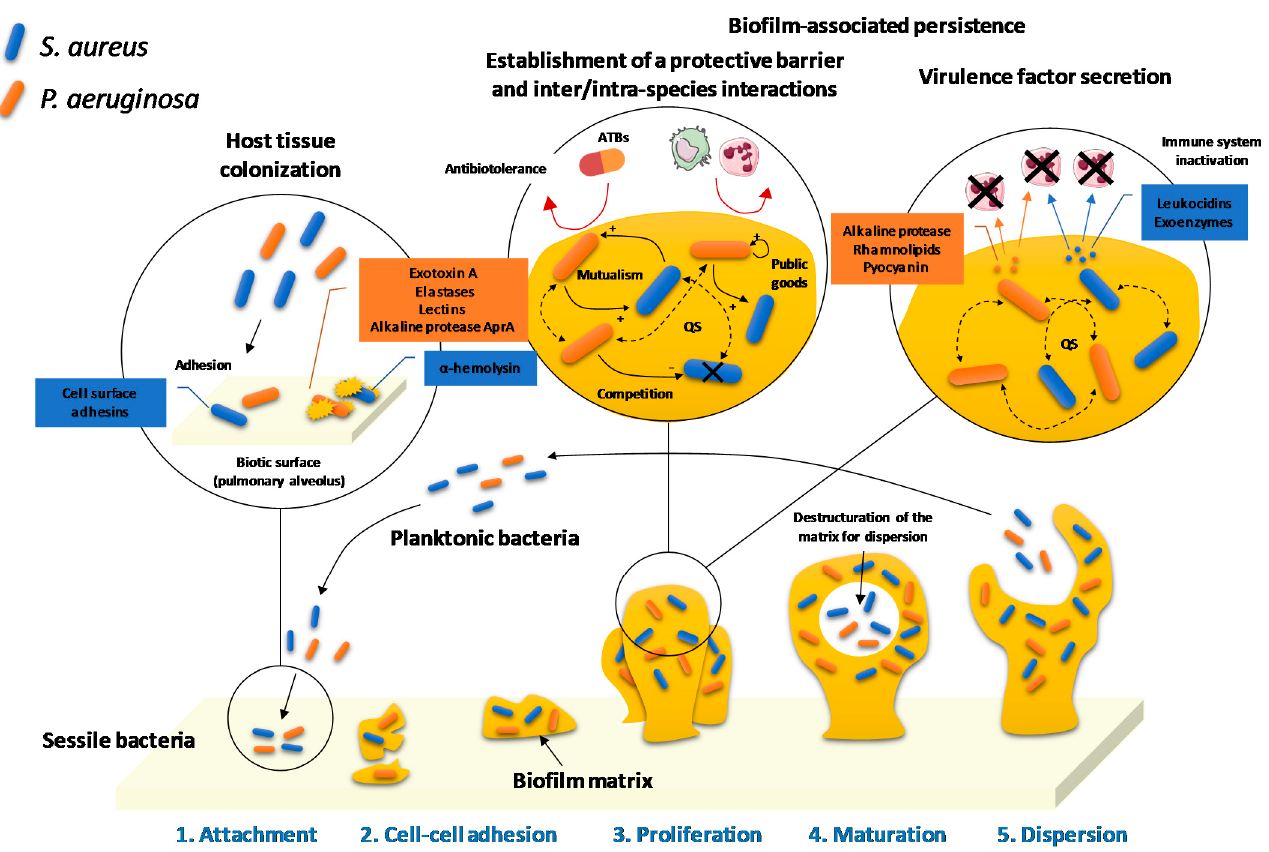
Figure 1. Host tissue colonization, biofilm development, invasion and persistence of P. aeruginosa during polymicrobial respiratory infections.